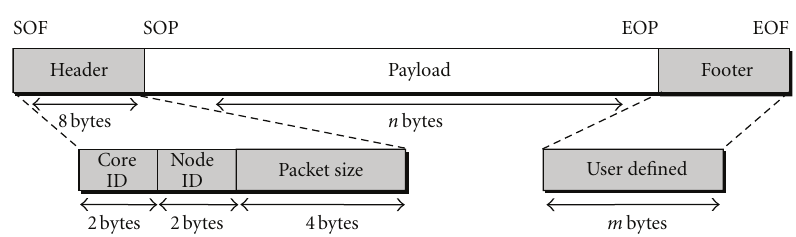
Figure 4: AIREN packet structure.